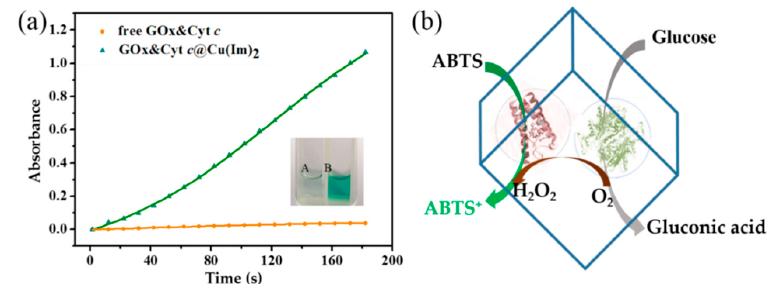
Figure 5. ( a ) Kinetic performance for GOx and Cyt c, and GOx-Cyt c @Cu(Im) 2 , and the chromogenic